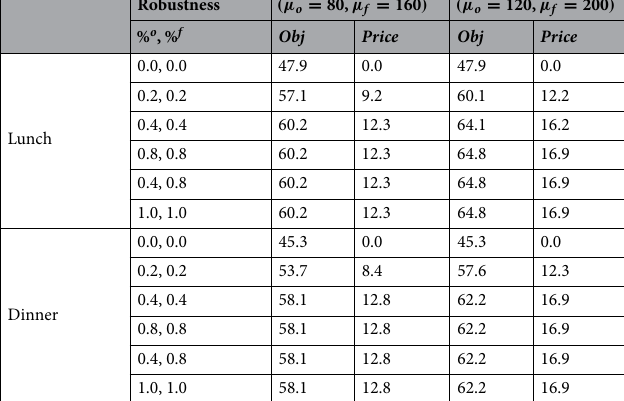
Table 6. Price of